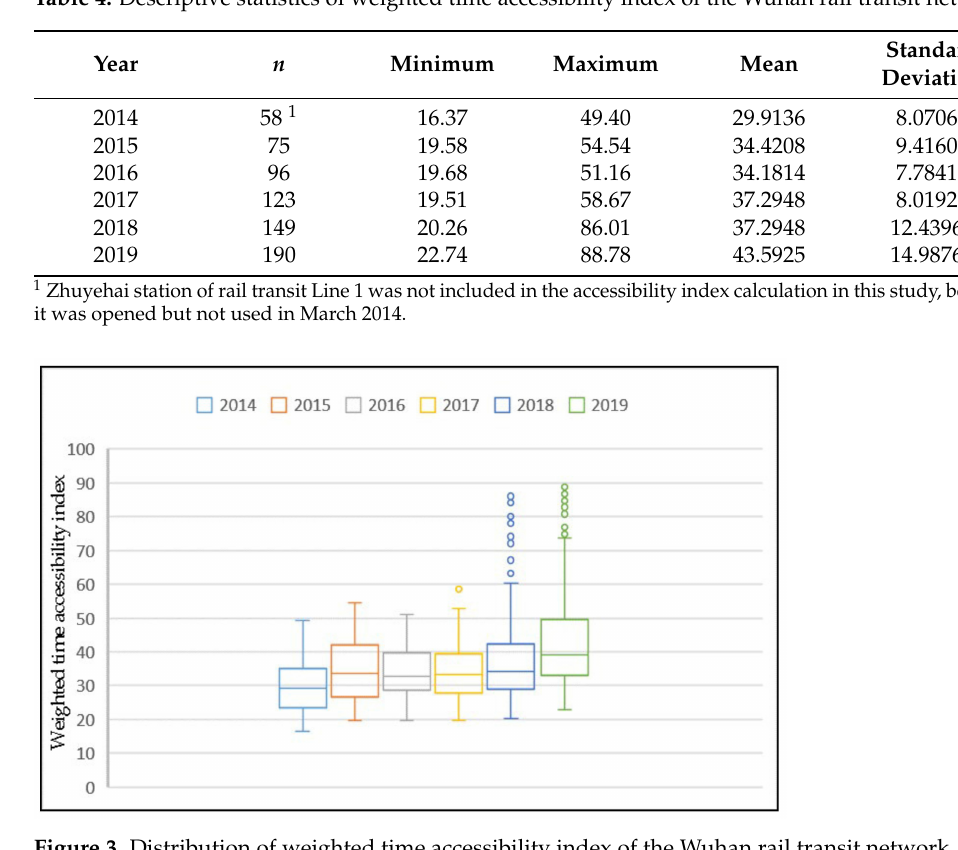
Figure 3. Distribution of weighted time accessibility index of the Wuhan rail transit network. Note: The unit of the weighted time accessibility index is